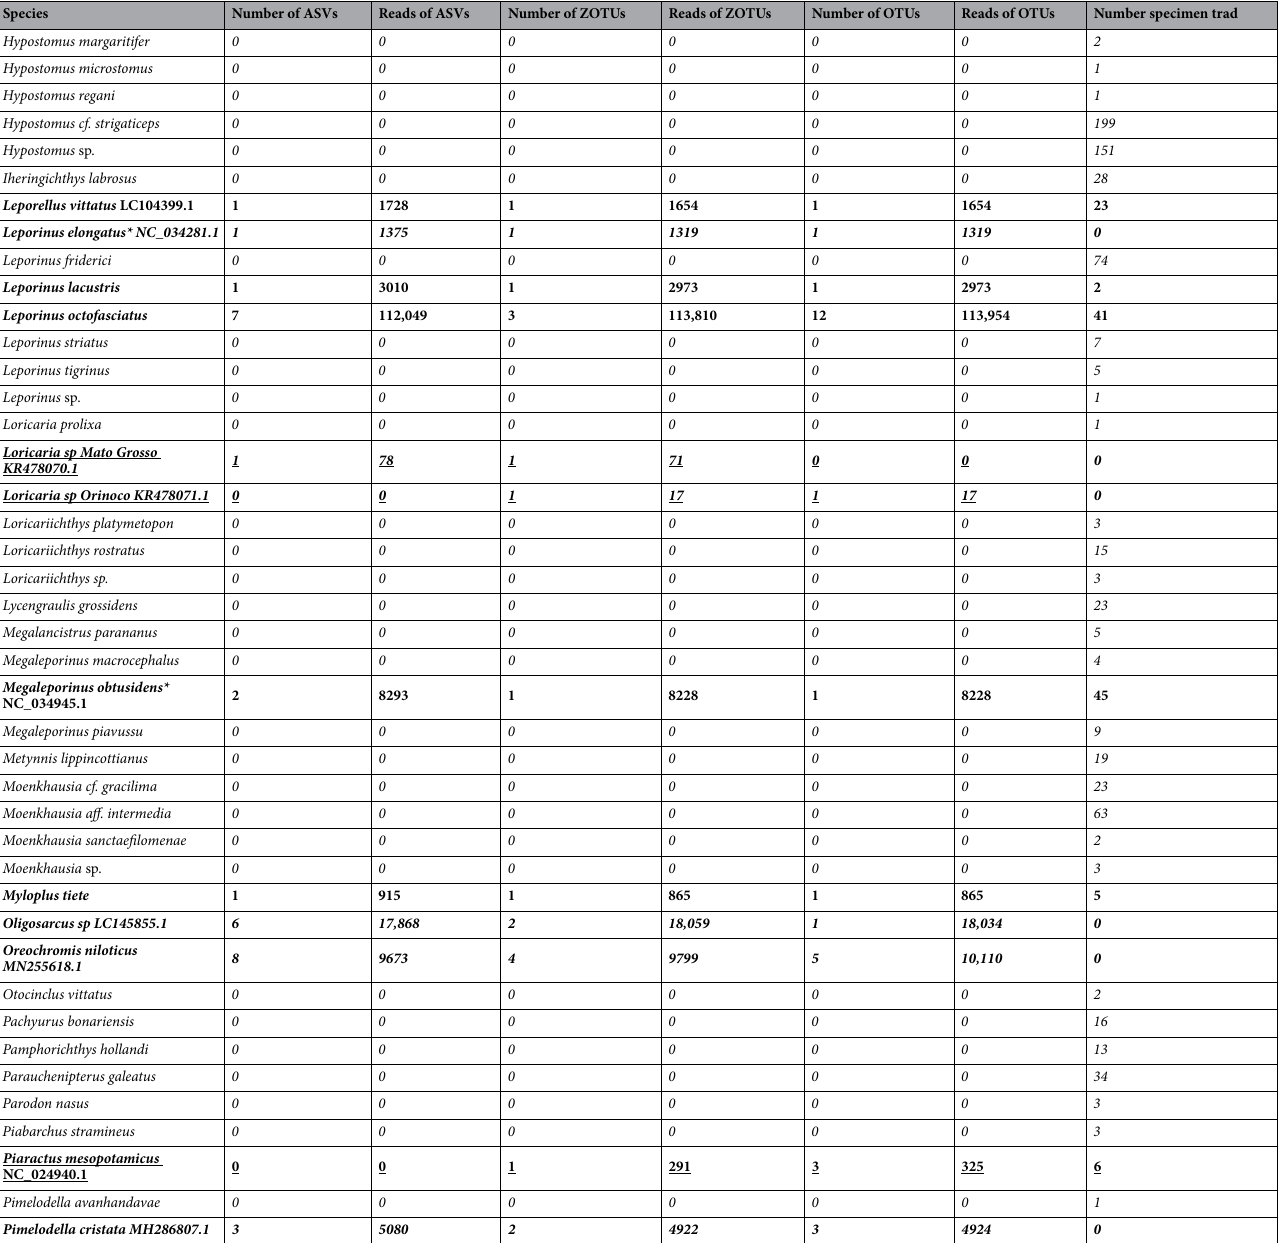
Table 2. Number of specimens sampled with traditional surveys (N. specimen trad.), species identified at level of > 97% similarity, the number of ASVs, ZOTUs, OTUs identified per species (possible intra-specific variation) and the number of reads per species after correction. Rows in bold are species identified in both traditional surveys and metabarcoding (29 in total), italics are species just identified by traditional surveys (93 in total), and bolditalics species just identified by metabarcoding approach (27 in total). In underline species that was not registered in one of the pipelines. Leporinus elongatus is now Megaleporinus obtusidens, but as both species names are in